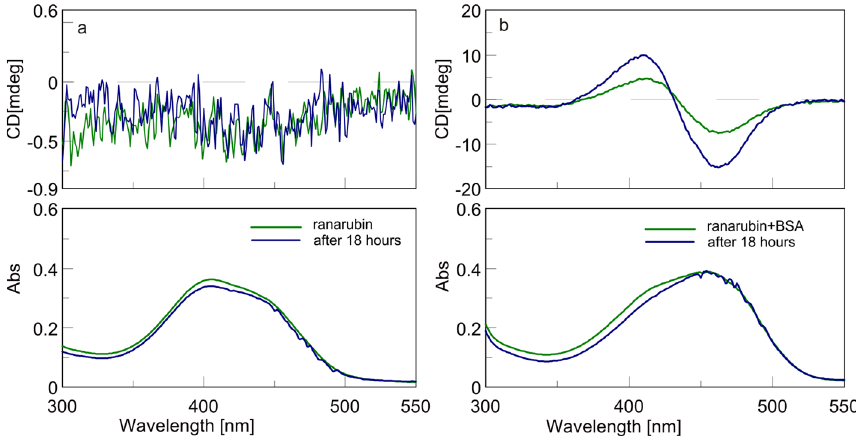
Figure 3. Spectral stability of: ( a ) bilirubin-10-sulfonate (ranarubin) in H 2 O, and ( b ) bilirubin-10-sulfonate (ranarubin) in H